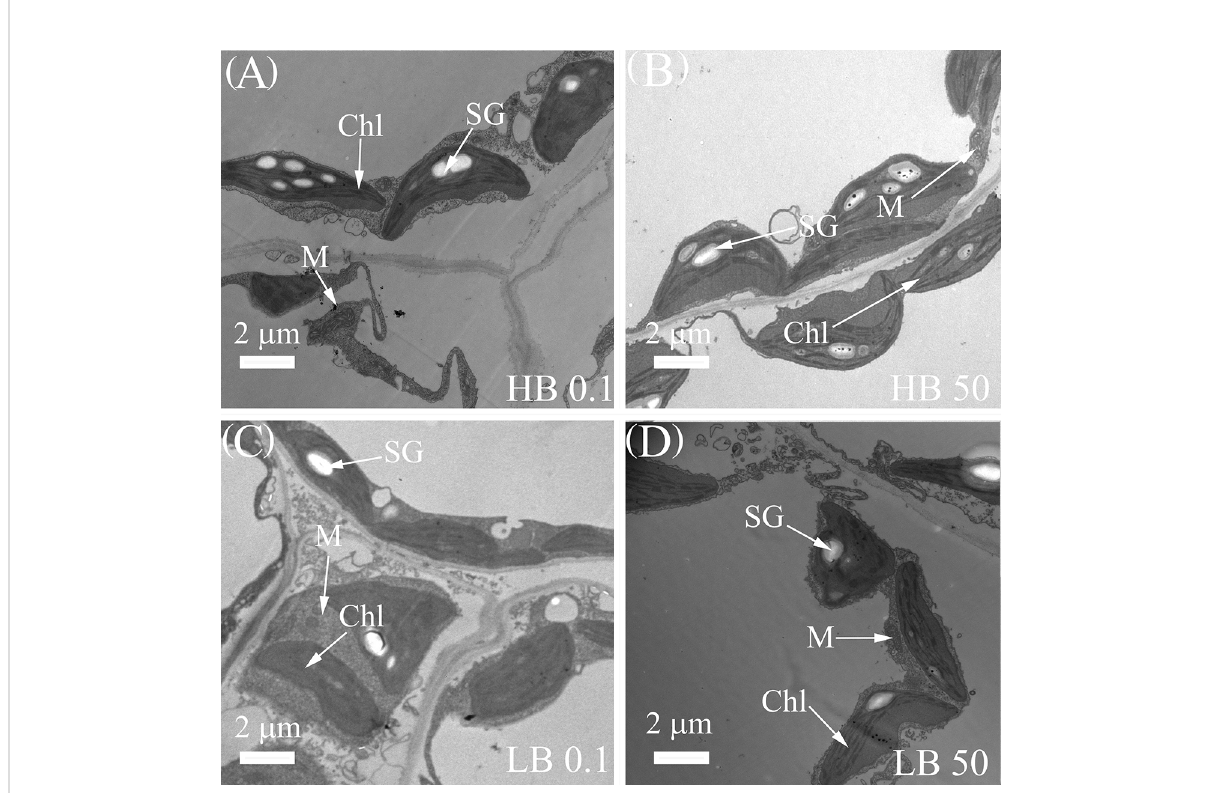
FIGURE 4 Changesinthesubcellularstructure of leavesofcontrastingBef fi ciencysugarbeetcultivars. TheseedlingsweretreatedwithBde fi cient(0.1 m M H 3 BO 3 , B0.1)treatmentinHB0.1 (A) andLB0.1 (C) andBsuf fi cient(50 m M H 3 BO 3 ,B50)treatmentsinHB50 (B) and LB50 (D) .Chl, Chloroplast;M, Mitochondrion; SG,StarchGranule.